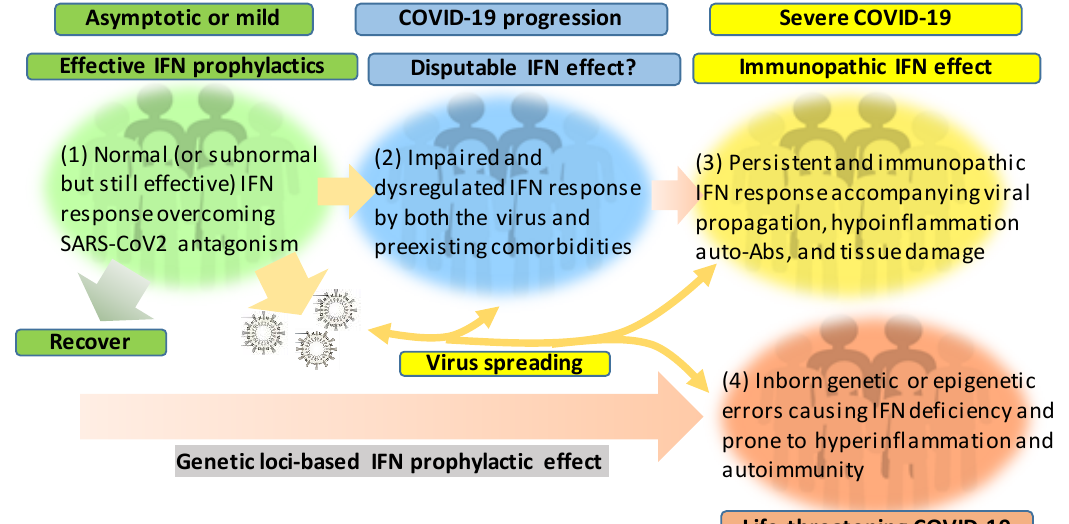
Figure 2. Schematic of patient cohorts of SARS-CoV-2 infections based on the severity of COVID-19 and underlying IFN responses. The effective or dysregulated interferon (IFN) response underlies the development of severe and life-threatening COVID-19. The dysregulation of IFN response can progressively result from the viral antagonism/virulence, preexisting comorbidities, gender/age inclination, and exacerbated hyper inflammation, with the extremal genetic flaws impairing the IFN signaling pathway. Hence, the prophylactic or therapeutic effect of IFN therapies should be designed and more dependent on the spatiotemporal kinetics of IFN responses during SARS-CoV-2 infection and the disease progression. In addition to its evolving antagonism to divert the host IFN response, the high contagiousness of SARS-CoV-2 also comes from the efficient virus infection and spreading by the non-hospitalized individuals who are asymptomatic or only have mild signs.